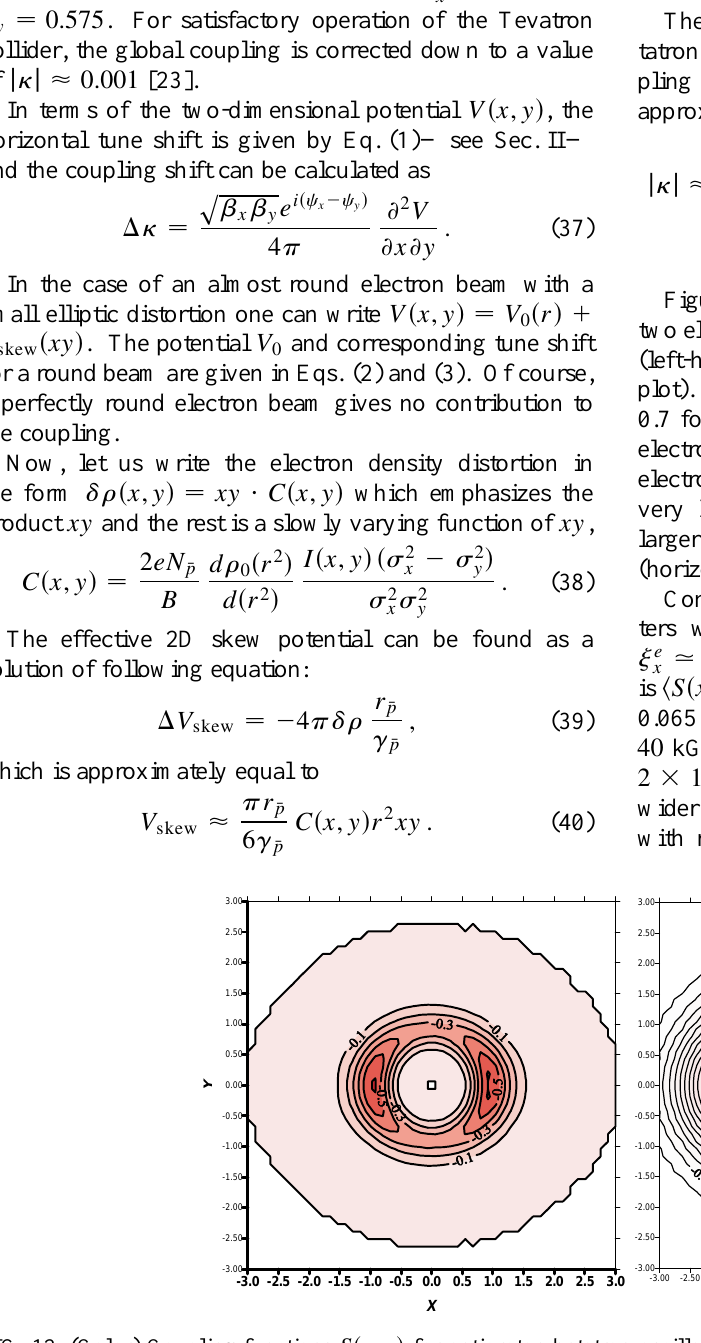
FIG. 12. (Color) Coupling functions S (cid:2) x , y (cid:3) for antiproton betatron oscillations with thin (left) and wide electron beams (right). x and y coordinates are given in units of s x